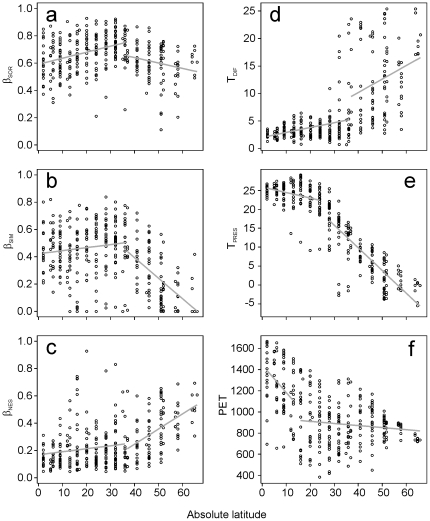
Latitudinal patterns of beta diversity and its potential explanatory variables: (a) total dissimilarity in assemblage composition (βSOR), (b) spatial turnover (βSIM), (c) nestedness-resultant dissimilarity (βNES), (d) temperature difference between LGM and the present conditions (TDIF), (e) current temperature (TPRES) and (f) current potential evapotranspiration (PET).Fitted functions of piecewise regression are shown (gray lines).